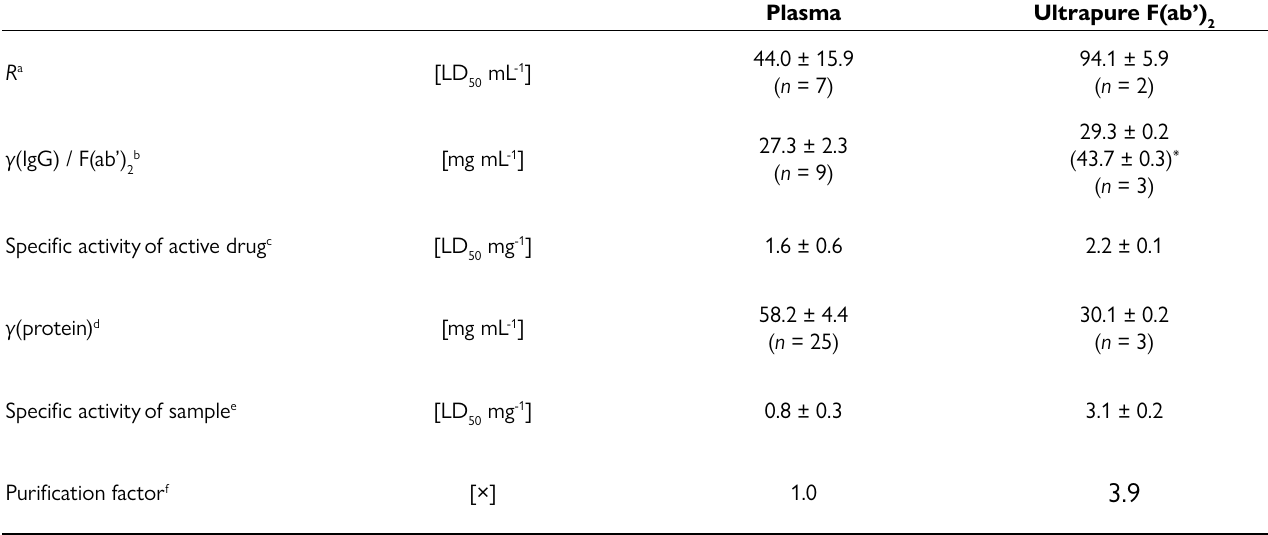
with specific activities. Purification factors obtained through manufacturing procedure are indicated. Table 2. In vivo neutralization potencies of HHP and F(ab’) 2 Results are expressed as means from n independently performed experiments +/- standard deviation.